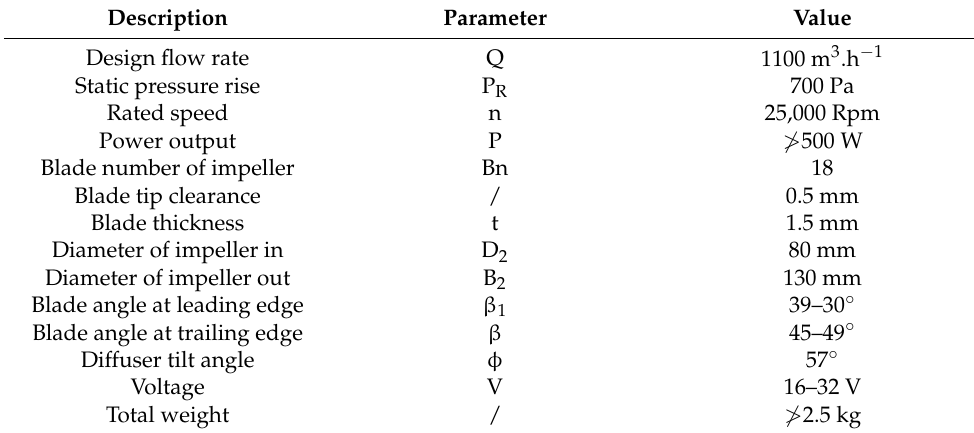
Table 1. Initial design parameters of the MIX-130 fan.